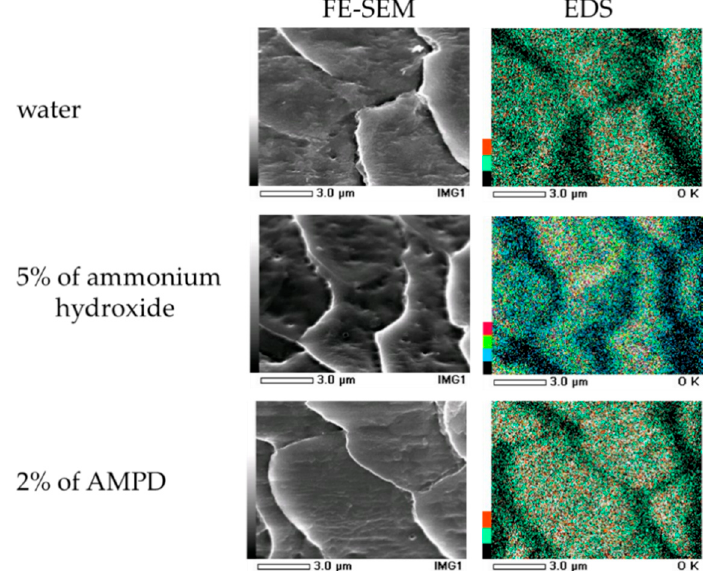
Figure 9. Oxygen mapping by EDS on the surface of human hair following treatment with 2% AMPD aqueous solution or 5% ammonium hydroxide as an alkaline agent. Strength is in order of strong, red, green, blue, black.